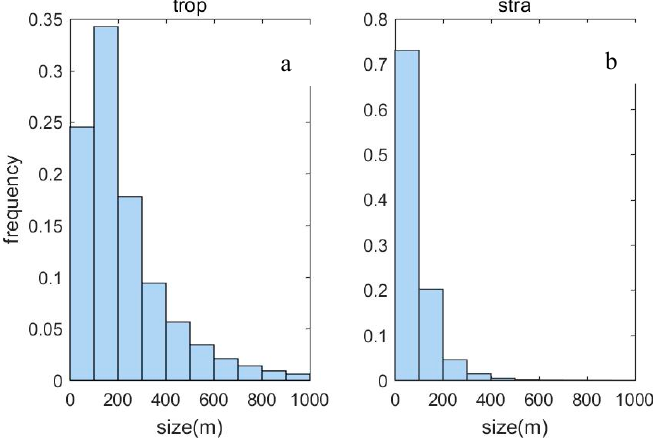
Figure 7. Turbulence overturn size from 2013 to 2018. ( a ) The frequency distribution in the troposphere, ( b ) the frequency distribution in the stratosphere.